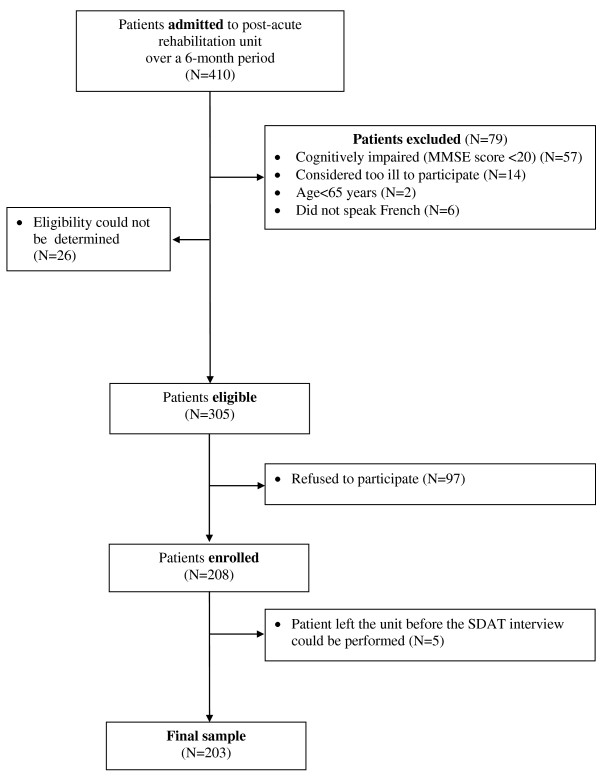
Study flow-chart.